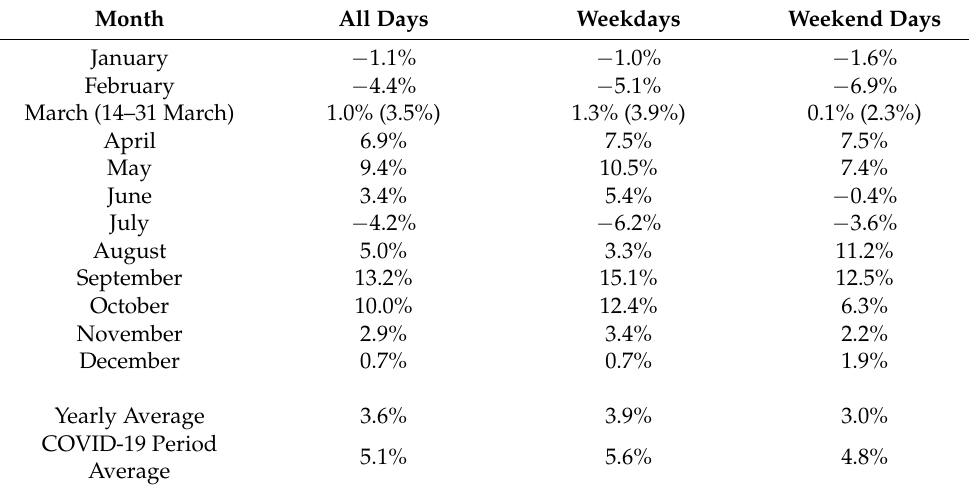
Figure 4. Total residential estimated non-temperature sensitive energy change for 2020 compared to a counterfactual using a 2018–2019 baseline, presented on a monthly basis as a simple composite average of feeders. Table 3. Change in energy use for 2020 compared to a 2018–2019 baseline for Feeders A–D showing monthly energy use after temperature normalization. Positive values indicate higher 2020 energy use compared to the counterfactual model